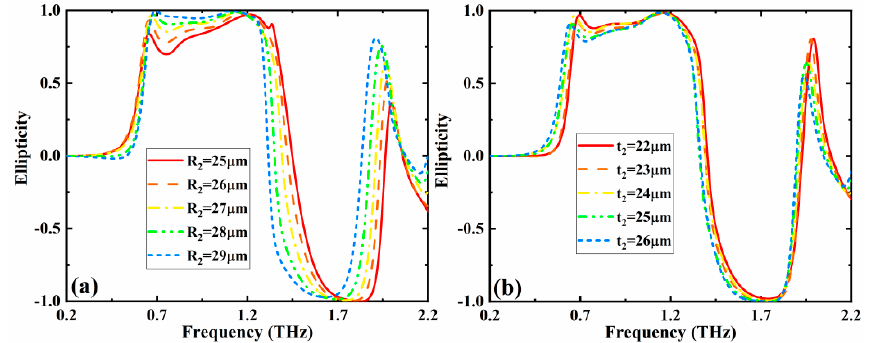
Figure 3. Effects of different ( a ) R 2 and ( b ) t 2 on the ellipticity when the conductivity of VO 2 and chemical potential of graphene are σ VO = 3 × 10 5 S/m and µ c = 0.05 eV, respectively.